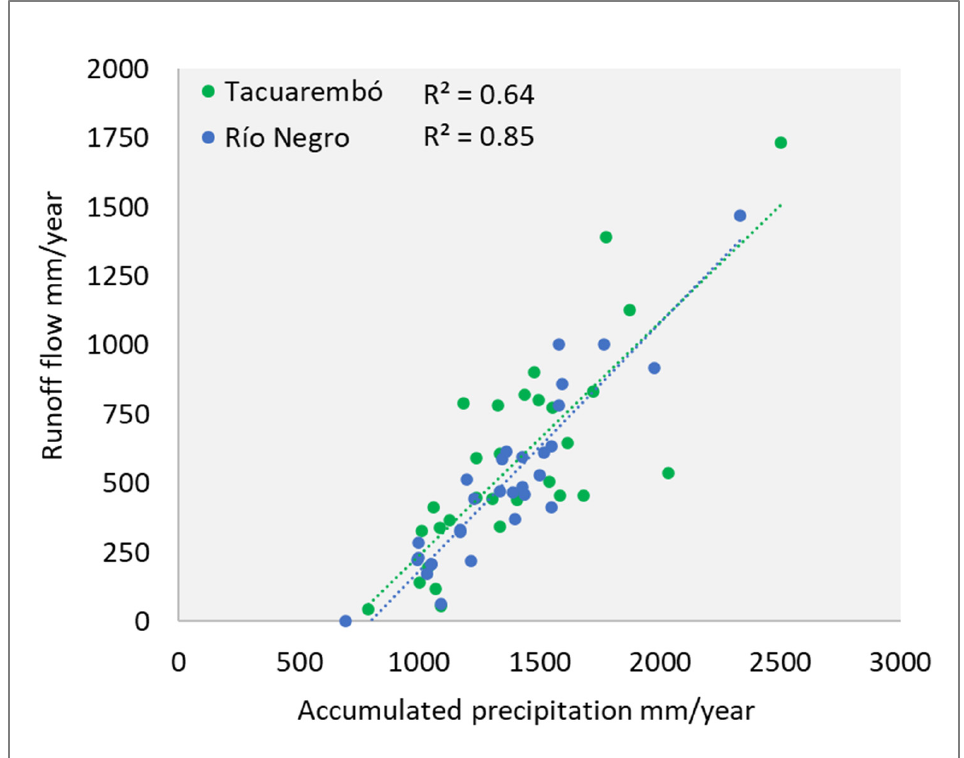
Figure 8. Correlation analysis between the annual runoff flow and the annual accumulated precip- itation for the period 1984–2013 of the two basins analyzed.